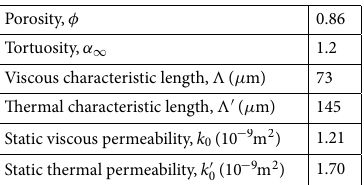
Table 1. Porous parameters of the considered Aegagropilae fiber